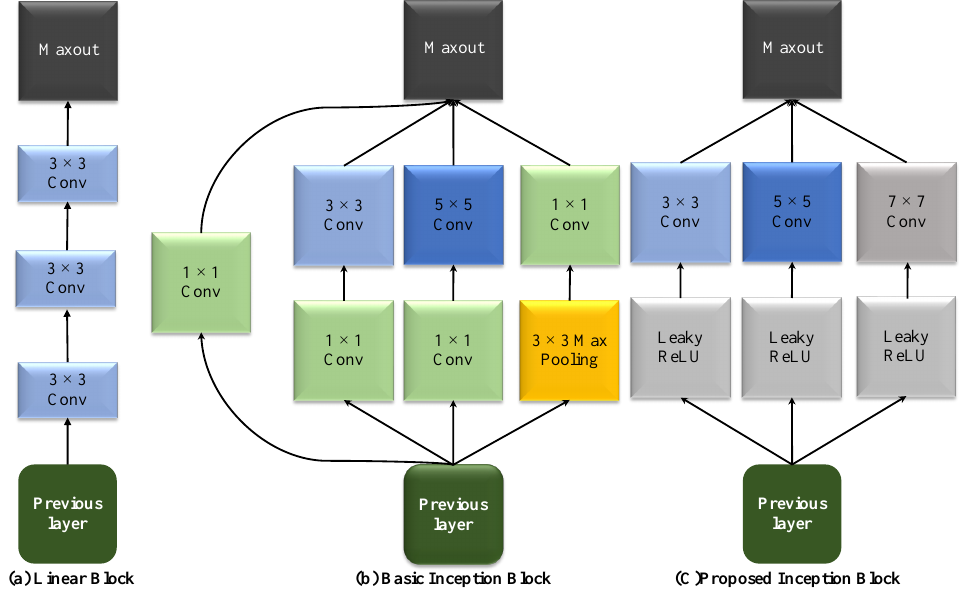
Figure 3. Comparison of different types of blocks used for feature extraction ( a ) Linear or single path type block, ( b ) Inception-based multipath block, and ( c ) Our proposed multipath Inception